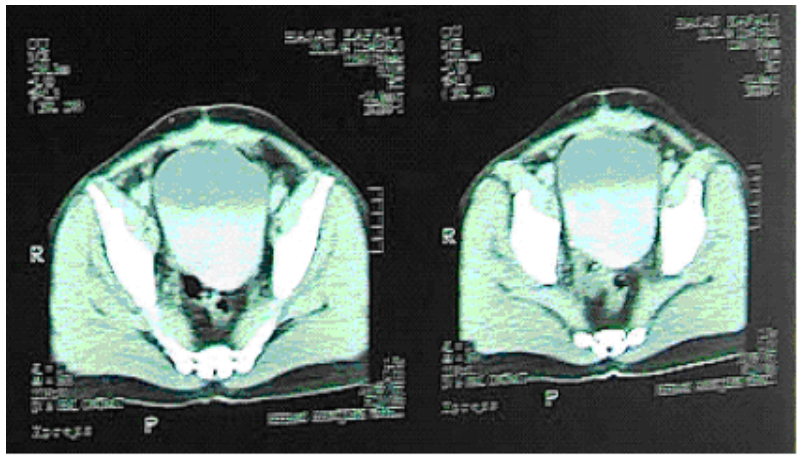
FIGURE 6 . Hypodens lesion seen on right posterior side of bladder in postoperative 6th month on